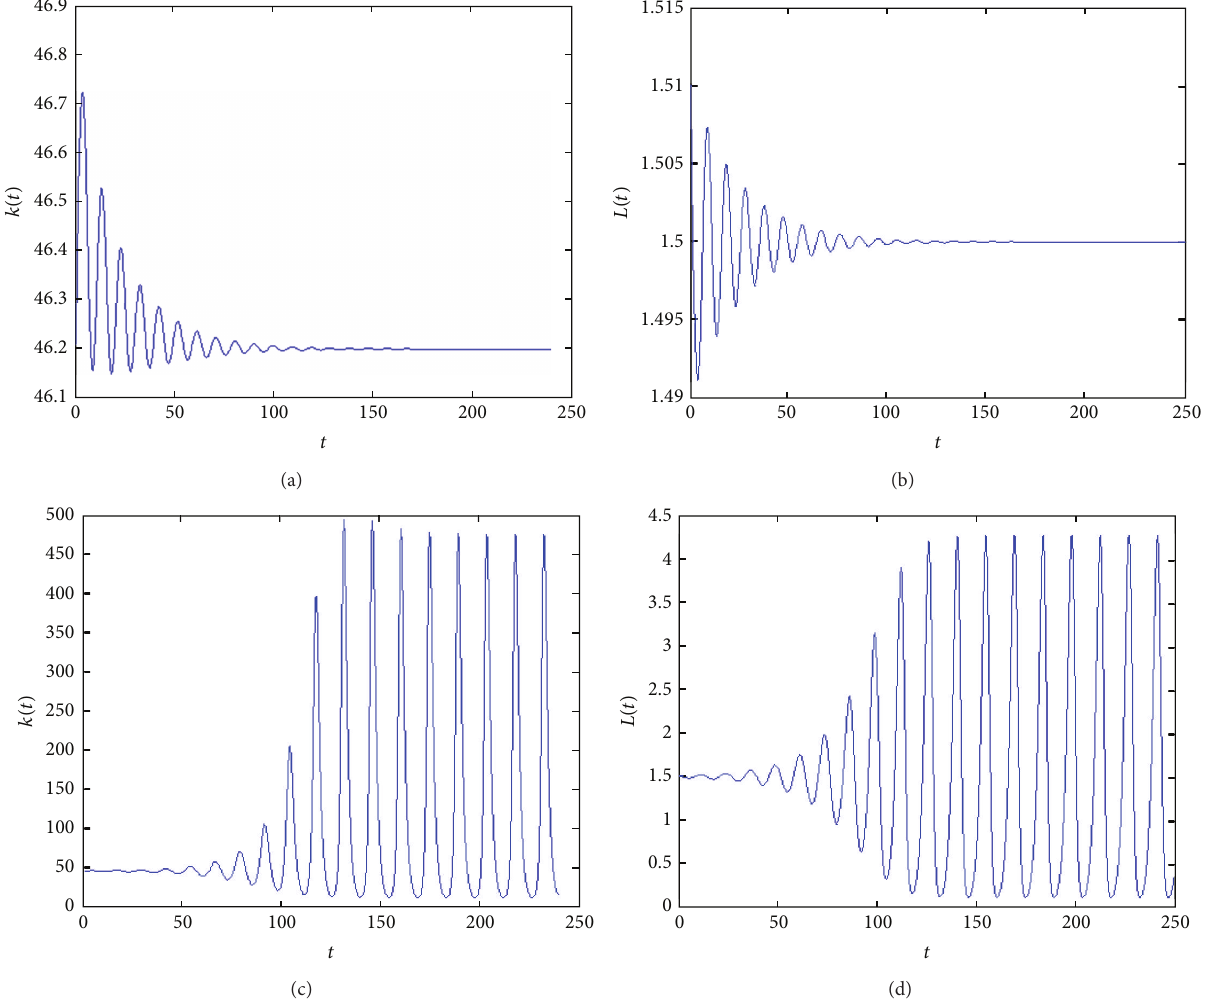
Figure 1: (a) Time evolution of size capital per worker ( 𝜏 = 2.3) ; (b) time evolution of population ( 𝜏 = 2.3) ; (c) time evolution of capital per worker ( 𝜏 = 3.3) ; and (d) time evolution of population ( 𝜏 = 3.3)